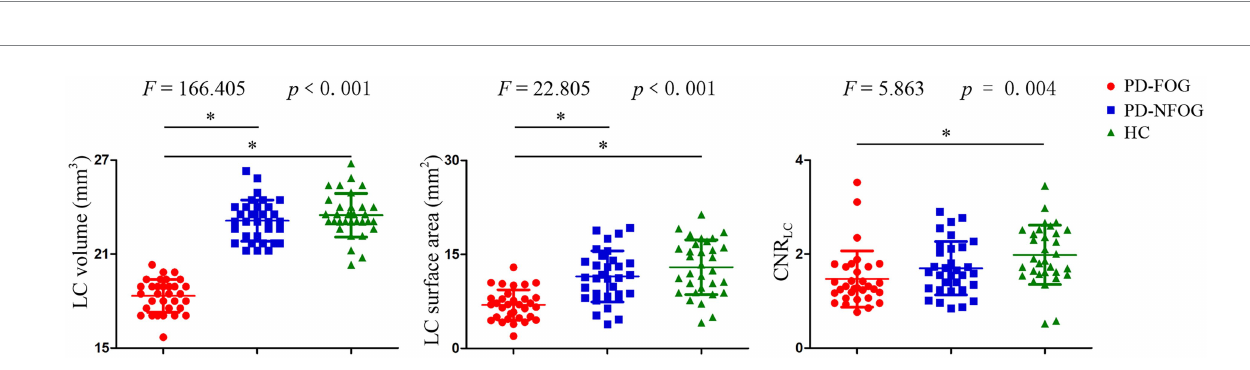
FIGURE 4 LC volume, surface area and CNR among PD-FOG, PD-NFOG and HC groups. CNR, contrast to noise ratio; LC, locus coeruleus; * p ≤ 0.001.